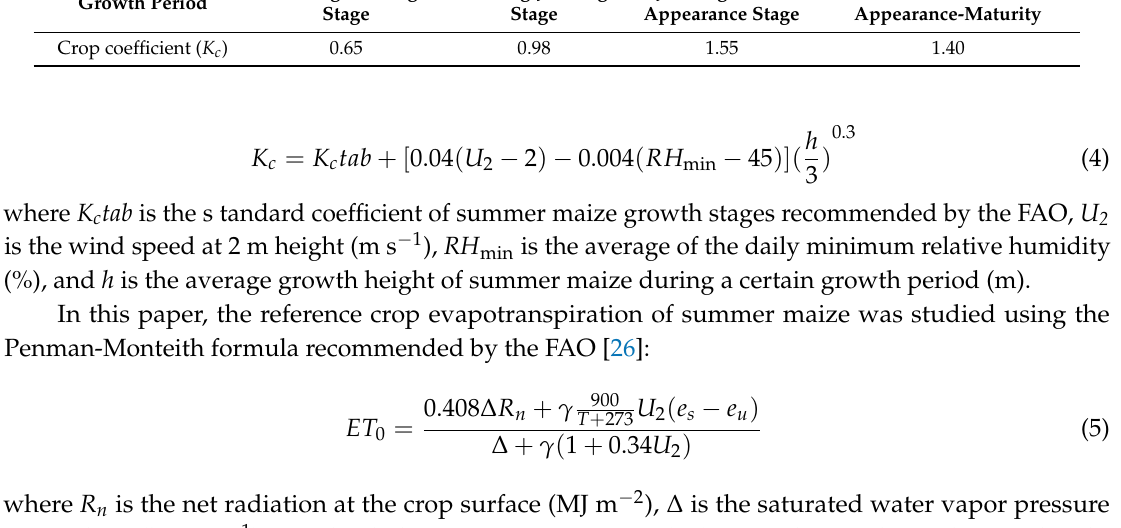
(Table 3): (1) the bounded probability distribution function (the range of random variable X is ( m , n )), (2) the non-negative probability distribution function (the random variable X is taken as a function of the random variable X ), (3) the non-negative probability distribution function (random variable X ranges from ( µ value range)), and (4) the generalized distribution